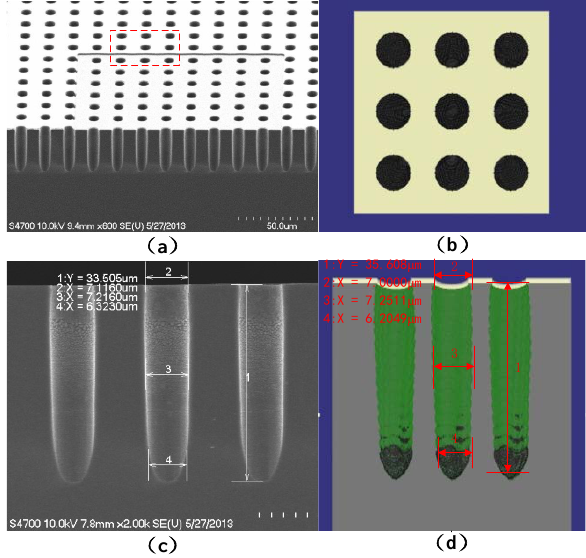
Figure 10. The experimental photography ( a , c ) and simulation ( b , d ) of porous structure. Table 2. Typical results of deep holes in different locations.